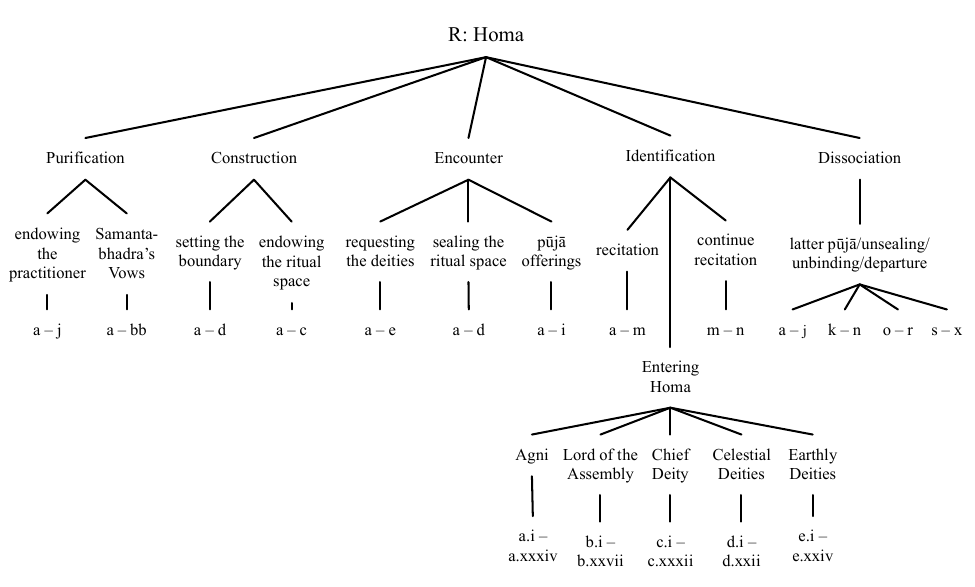
Figure 4. Syntax of Homa.